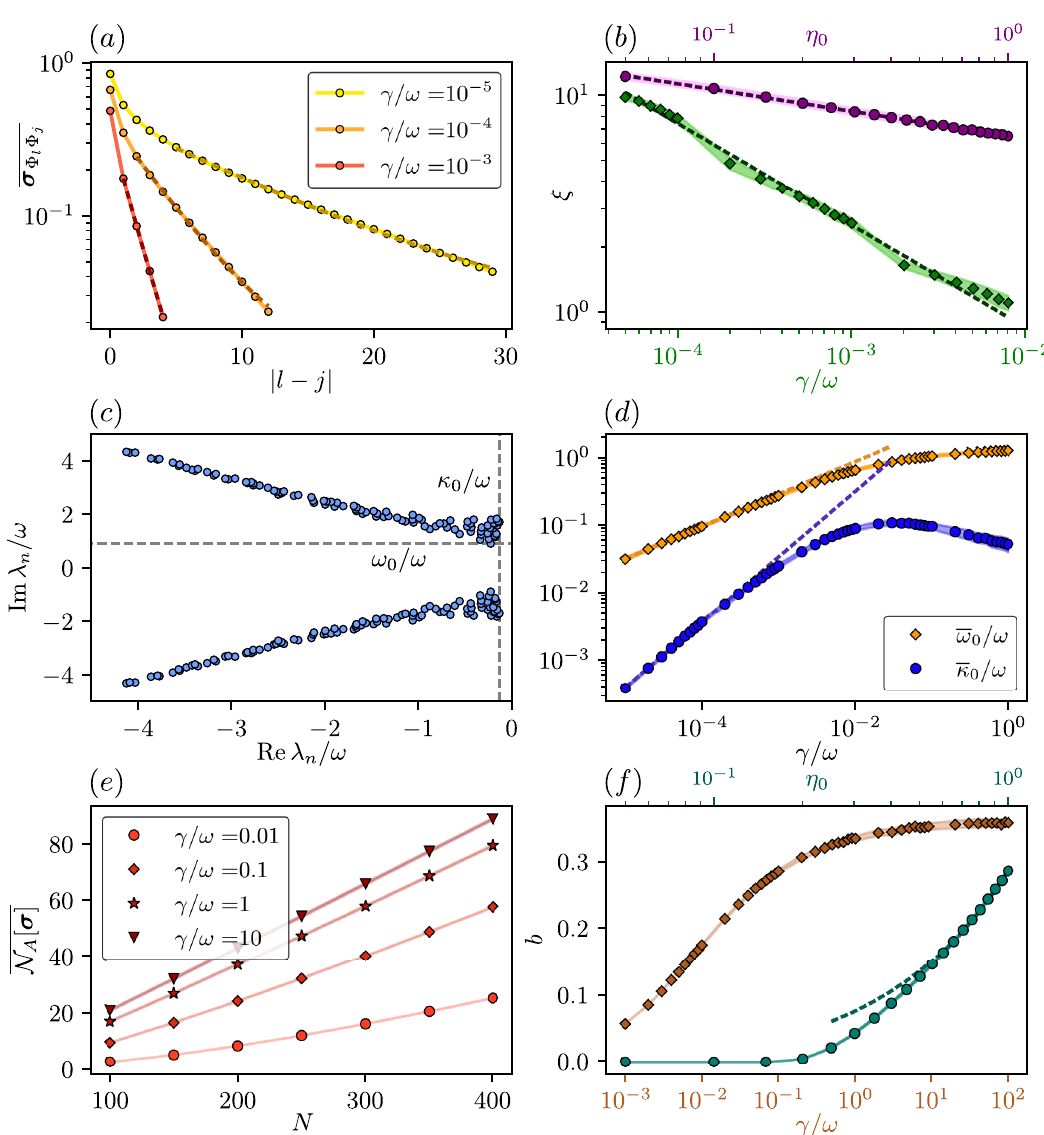
Figure 5: (a) Averaged real space correlations σ Φ for a system size of N = 200, Φ i l η = 1 and averaged over n = 500 random measurement settings. (b) Scal- 0 sample ing of the correlation length ξ with increasing γ (green markers) and η (purple 0 = 500. The shaded region corresponds to the markers) for N = 200 and n sample variance between realizations. The systematic errors for the green line can be at- tributed to heuristics in finding the exponential tails (darker dashed lines) in (a). The green dashed line corresponds to the fit ξ ∼ γ − α with α = 0.478 , whereas the − β purple dashed line corresponds to ξ ∼ η with β = 0.226. (c) Riccati spectrum for 0 one realization of measurement operators with real (imaginary) gaps κ ( ω ). (d) 0 0 Scaling of averaged ω (orange markers) and κ (blue markers) with γ for a system 0 0 = 500. The orange (blue) dashed line corresponds to size of N = 200 and n sample ω ∼ γ δ with δ = 0.478 ( κ ∼ γ ε with ε = 0.968). (e) Finite size scaling of half 0 0 = 500 realizations. chain logarithmic negativity for half system averaged over n sample (f) Dependence of the linear scaling constant b on γ (brown) and η (turquoise) ob- 0 tained from the finite size scaling over system sizes from (e). The turquoise dashed line indicates a linear decay. For small measurement efficiencies the entanglement vanishes completely, in accordance to entanglement